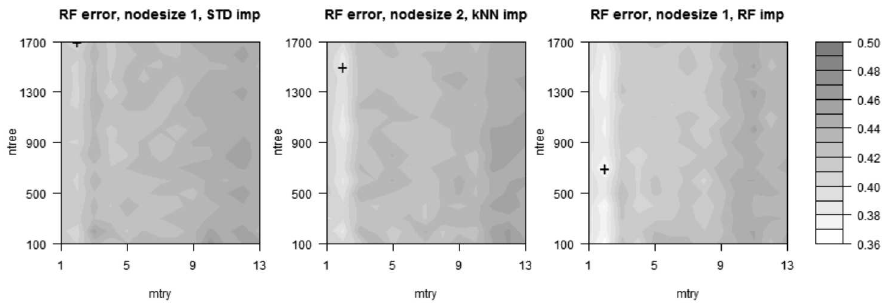
Figure 7. Results for Random Forest algorithm